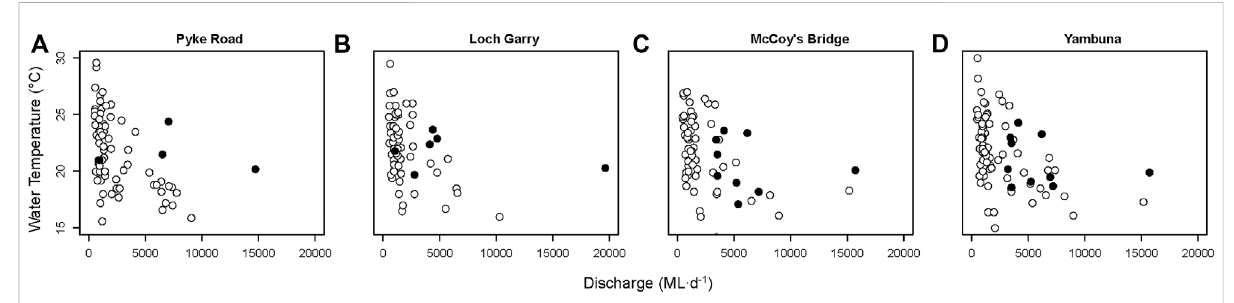
FIGURE 4 Temperature anddischargeconditions ofthespawningsamples. Each point isthecombinationof dischargeand water temperatureon theday ofsampling.Blackmarkersarethosesamplesforwhichgoldenpercheggsorlarvae weredetected,withwhitecirclesbeingnodetection.Panelsare arranged from upstream [ (A) -Pyke Road] to [ (D) -Yambuna] downstream.